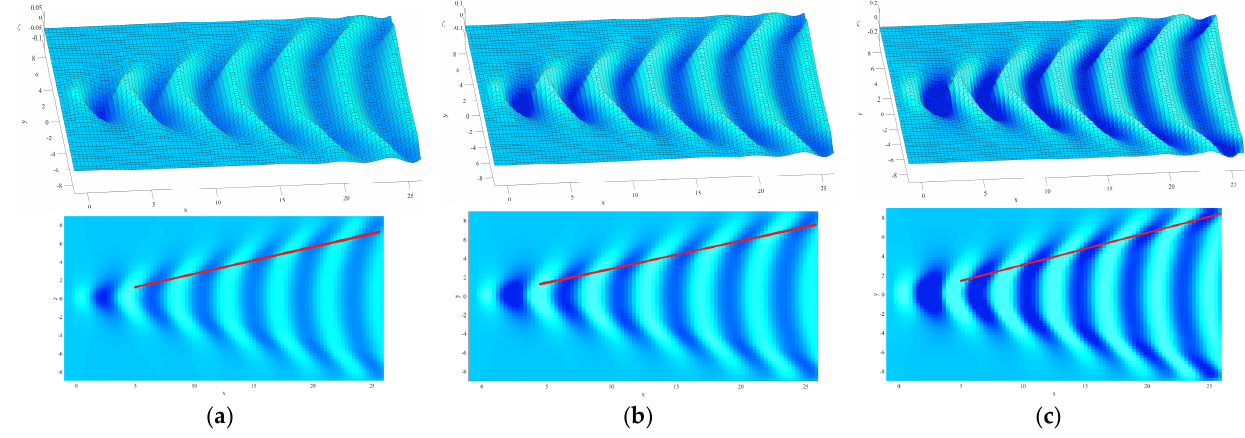
Figure 9. Perspectives and plans view of the free surfaces past Kelvin source, computed for the cases 𝐹′ = 0.8 : ( a ) 𝜖 (cid:4593) = 1.0, ( b ) 𝜖 (cid:4593) = 1.5, ( c ) 𝜖 (cid:4593) = 2.5 . The top three free surface patterns are the perspectives and the bottom three free surface patterns are the plans. The red line marks the edge of the wake angle in each plan view.